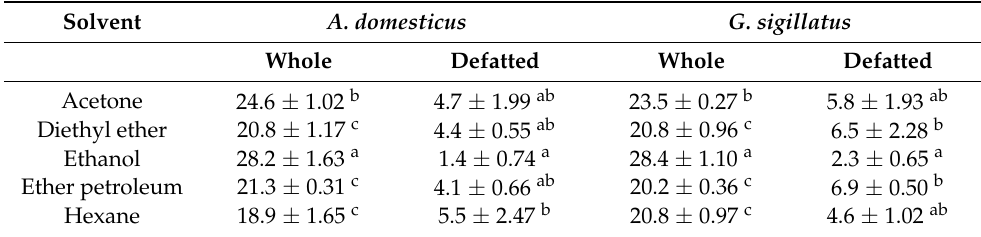
Figure 5. Schematic diagram showing the Soxhlet extraction technique [39]. Table 2. Ether extract content (g/100 g DM ± s.d.) of whole and defatted Acheta domesticus and Gryllodes sigillatus determined with different solvents. a,b,c —Represents in each column homogeneous groups in accordance with the Turkey’s test, within each cricket species ( p < 0.050). Results are means of three (defatted) and four (whole) replications